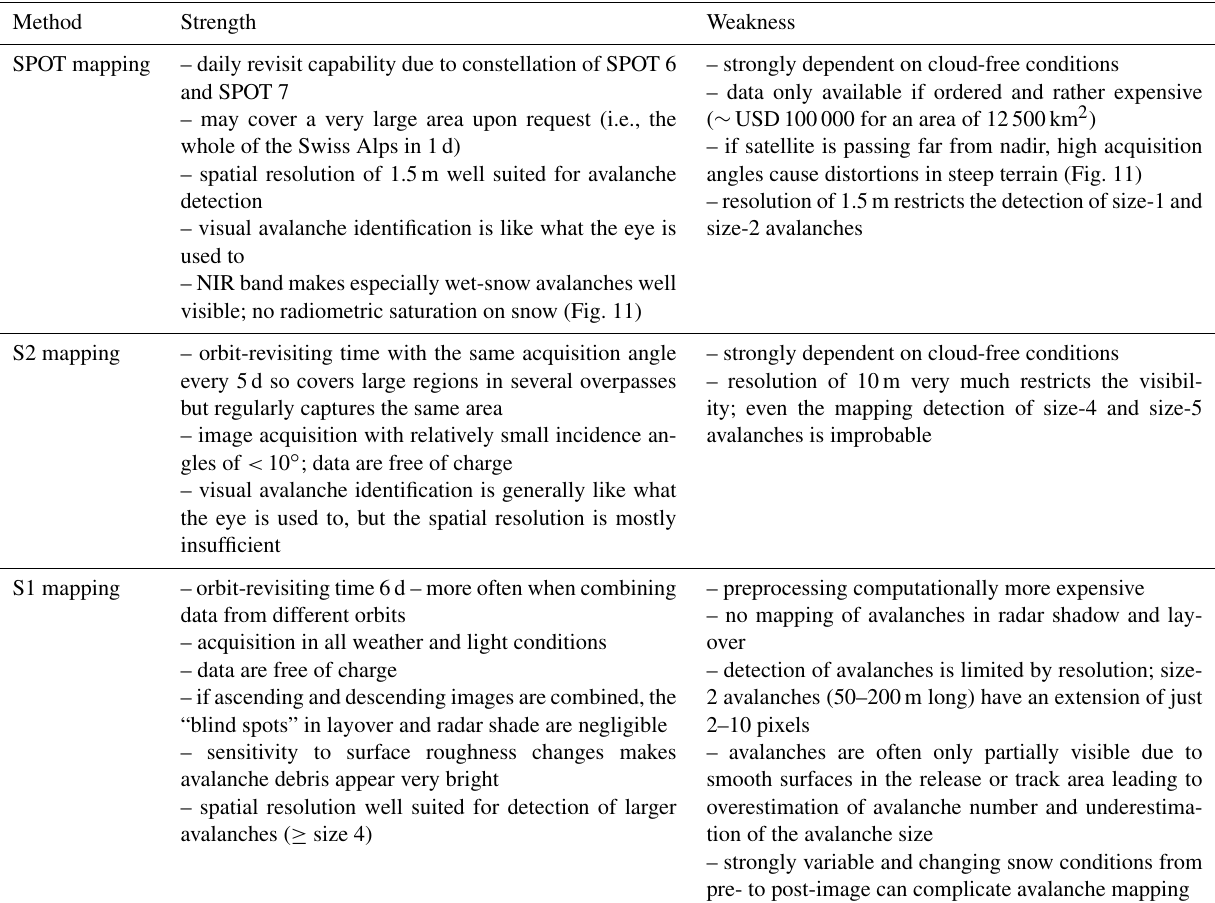
Table 6. Summary of the strengths and weaknesses of the methods